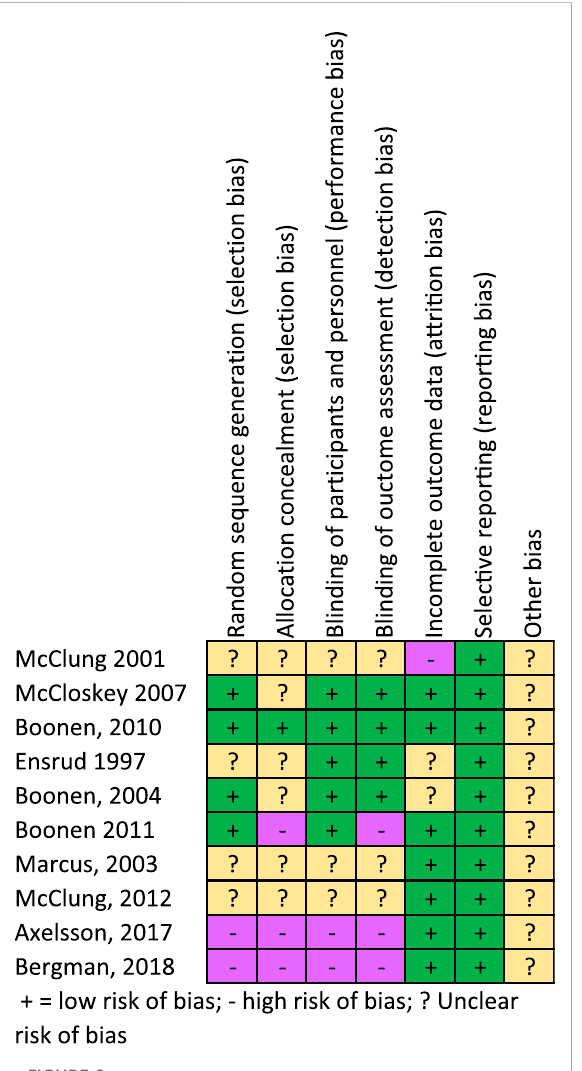
FIGURE 2 Risk of bias